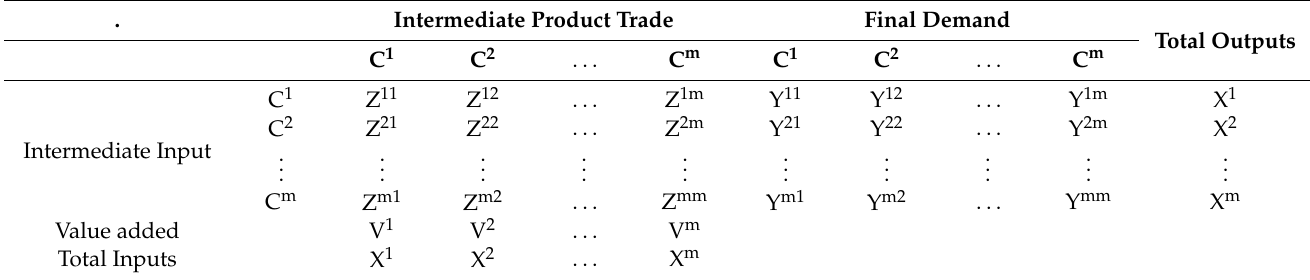
Table 1. The structure of the multi-regional input-output